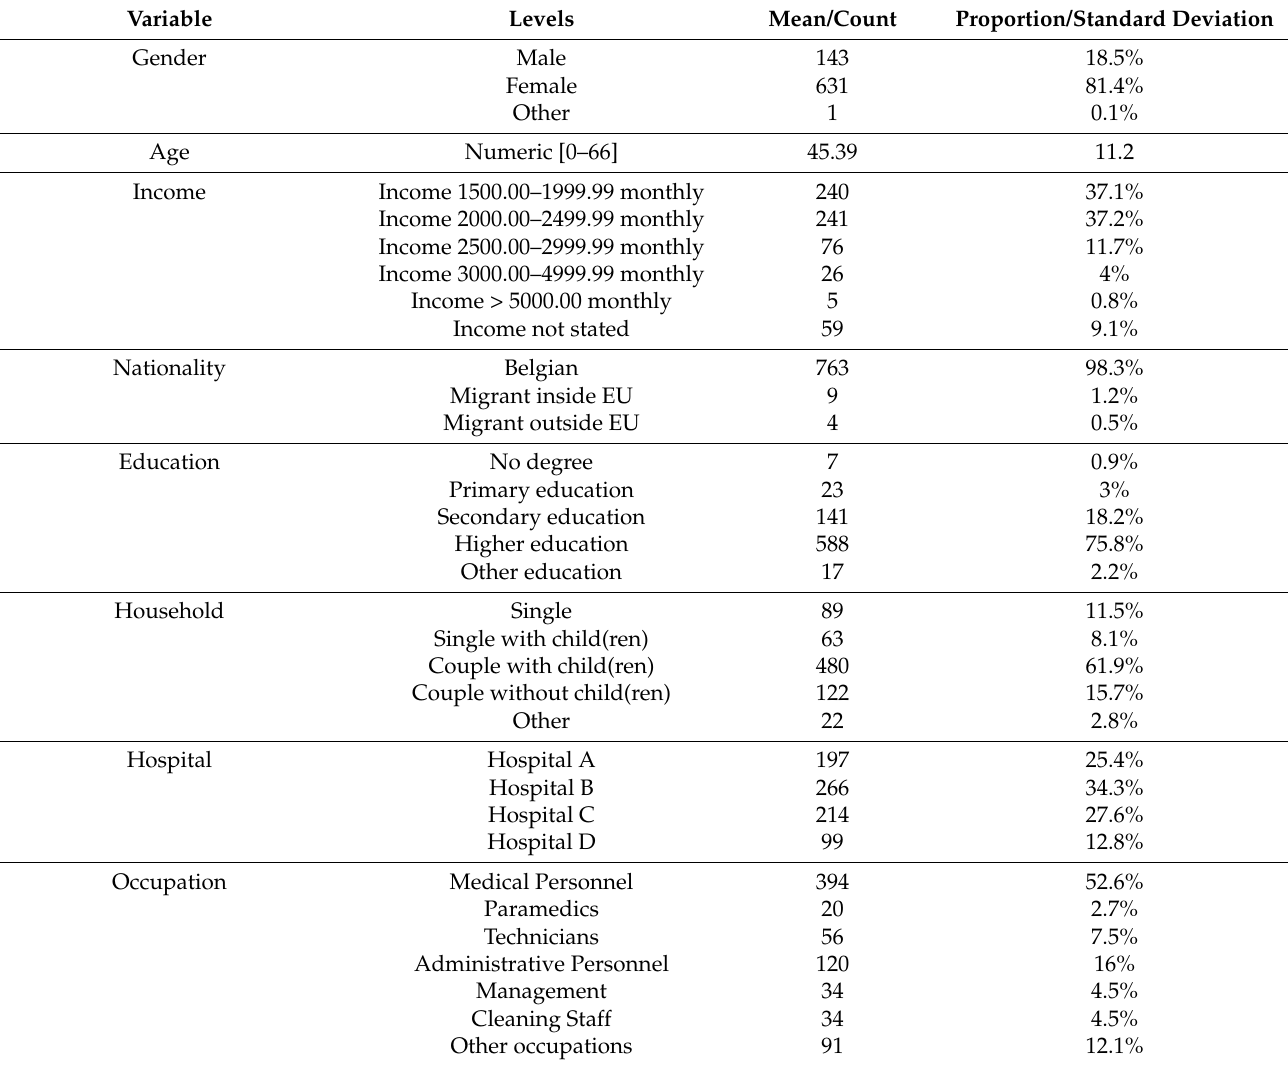
Table 1. Summary table of sample (N = 776); numeric variables state mean and standard deviation (SD); categorical variables state count and